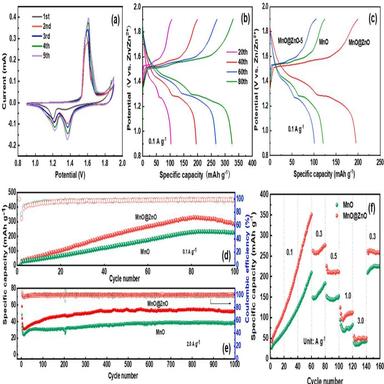
(a) CV profiles of MnO@ZnO electrode at 0.1 mV s − 1 . (b) GCD curves of different cycles. (c) GCD curves of MnO and MnO@ZnO electrodes with different ZnO deposition thicknesses. (d–e) Cycling performance and the coulombic efficiency at 2.0 and 0.1 A g− 1 . (f) Rate performance.